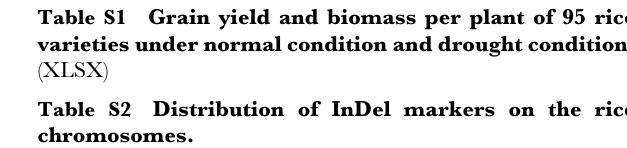
Table S1 Grain yield and biomass per plant of 95 rice varieties under normal condition and drought condition. Table S2 Distribution of InDel markers on the rice chromosomes. Table S3 The association analysis of drought tolerant traits with the diversity of 204 transcription factor promoters. R 2 indicates the proportion of phenotypic variation